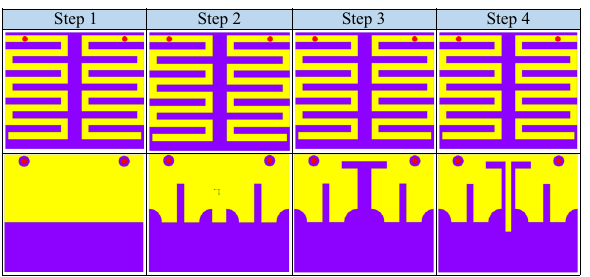
Figure 4. Optimization stages of the suggested MIMO antenna system.